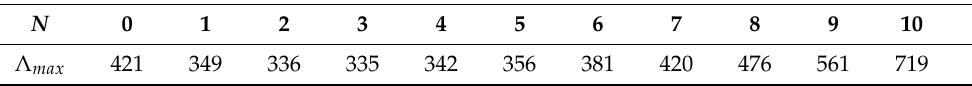
Table A5. First term of the eigenvalue Λ max for different N , constant n x = 100, and λ = 10 − 4 . For a visualization, see Figure